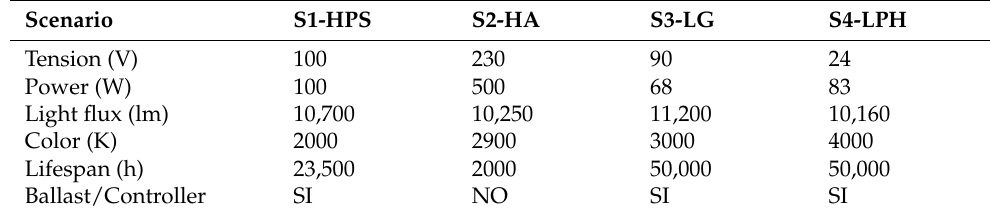
Table 3. Results of lighting system